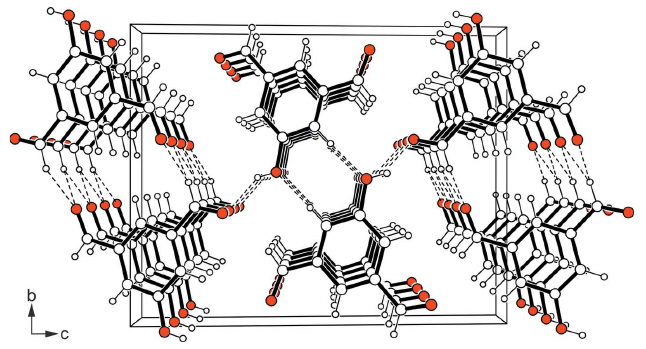
Figure 9 Mode of intermolecular non-covalent interactions in the crystal structure of 3 . The cyclic supramolecular synthons are marked by colour highlighting.